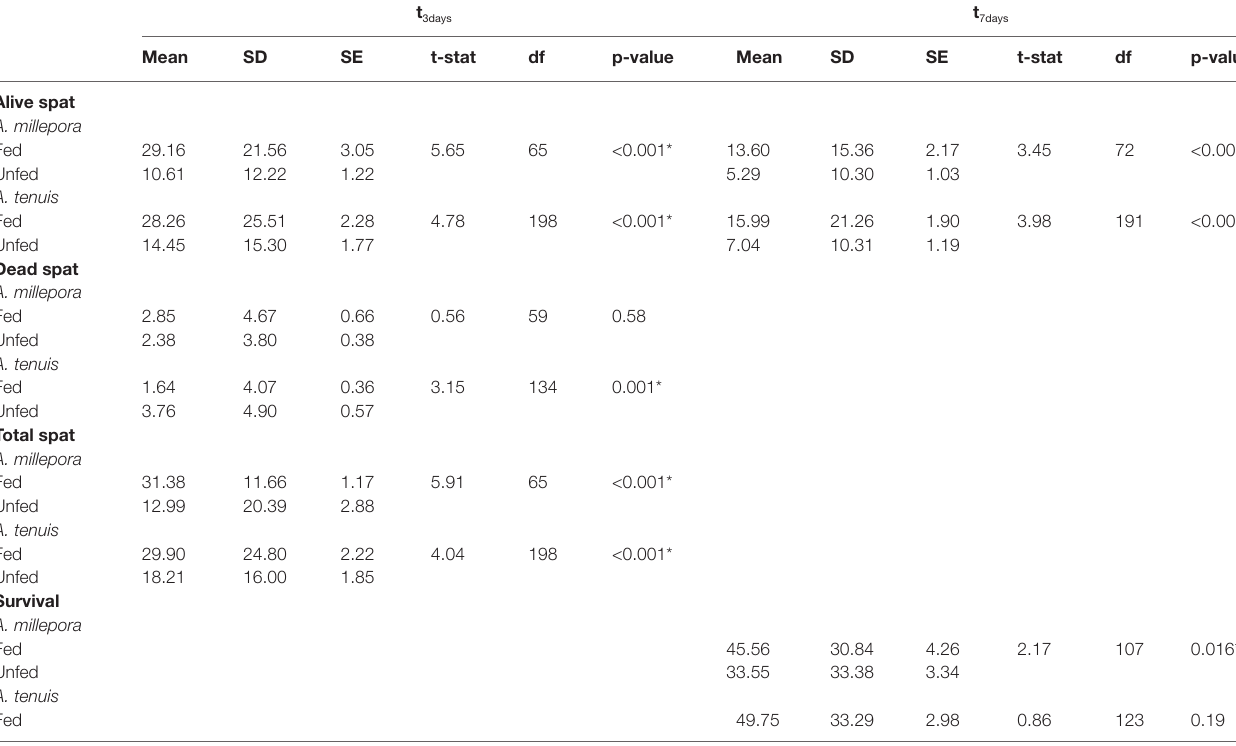
TABLE 1 | Observed mean, standard deviation (SD), standard error (SE), t-statistic, degrees of freedom (df), and p values for each t-test performed at either three (t 3days ) or seven days (t 7days ) after the introduction of settlement cues.